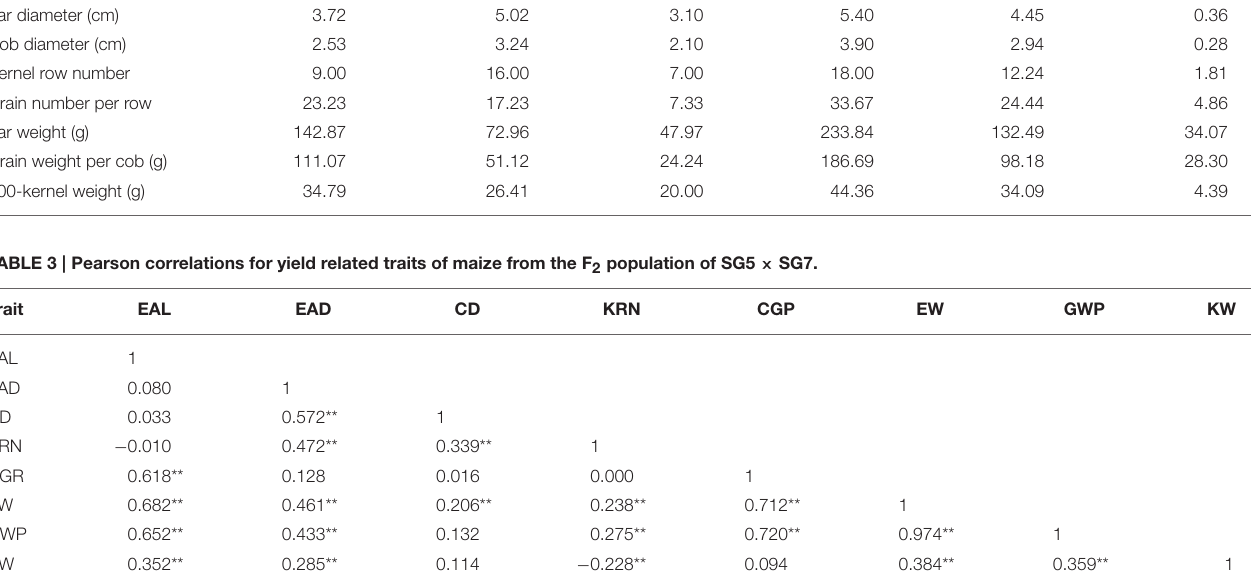
TABLE 2 | Descriptive statistics of traits in the F 2 mapping population of maize derived from the cross of SG5 and SG7. Trait SG5 (P1) SG7 (P2) Min Max Mean Std. Dev . Ear length (cm)